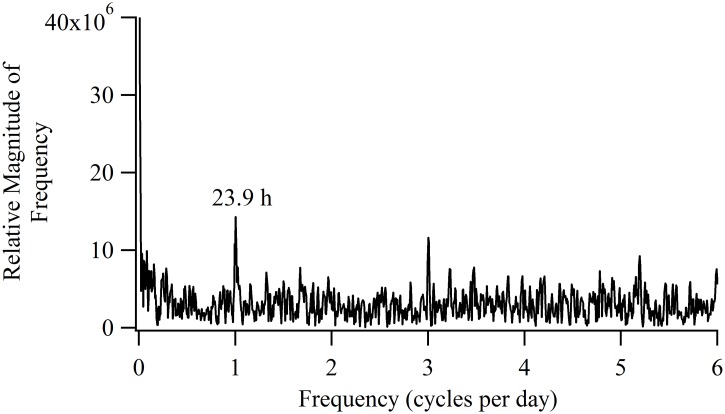
Fast Fourier transform-generated periodogram for depth data of Sharks 30.The high amplitude peak at 1 cycle day-1 is indicative of a diel rhythm in the vertical movements of the shark.